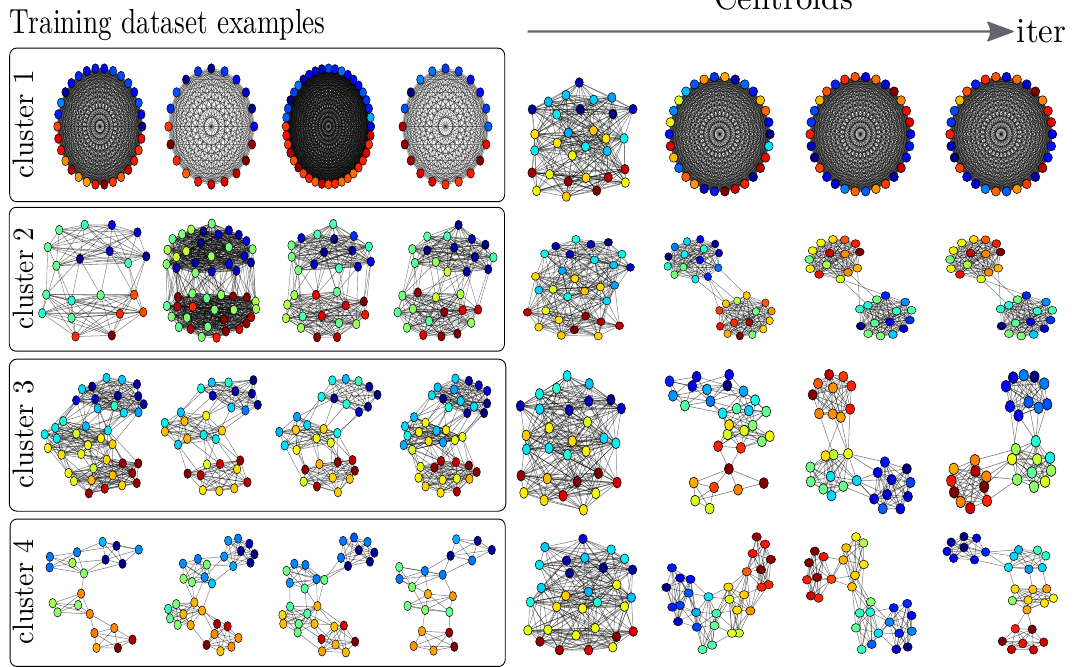
Figure 15. ( left ) Examples from the clustering dataset, color indicates the labels. ( right ) Evolution of the centroids of each cluster in the k -means clustering, from the random initialization until convergence to the final